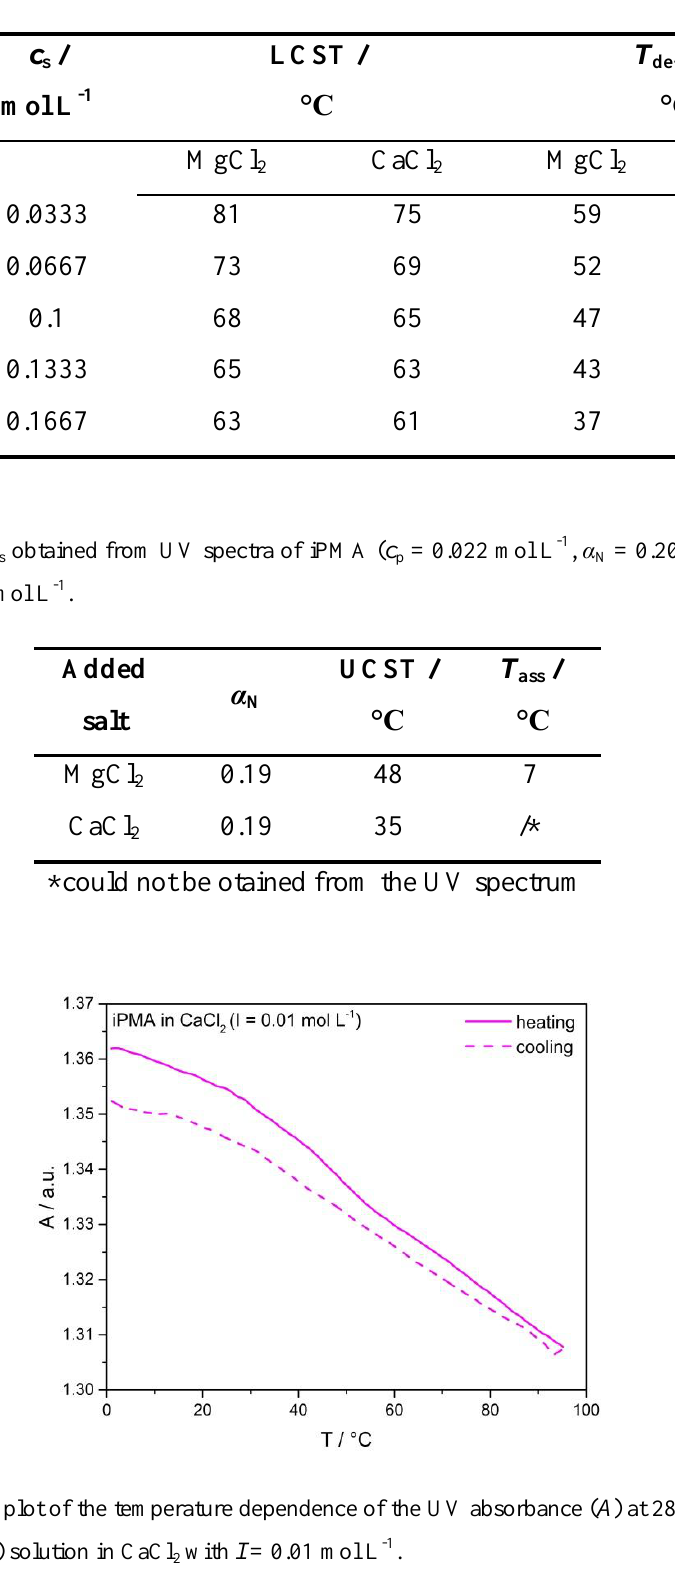
Table S6. LCST and T obtained from UV spectra of aPMA ( c de-ass and in CaCl with I = 0.1, 0.2, 0.3, 0.4 and 0.5 mol L -1 . 2